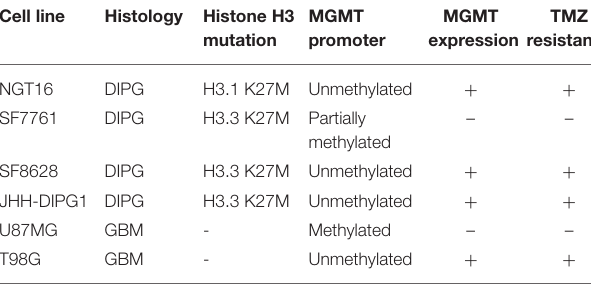
FIGURE 4 | SF7761 and U87MG are sensitive to temozolomide (TMZ). Cell viability assays showed that cell lines with reduced MGMT expression, SF7761 and U87MG, are sensitive to TMZ, whereas NGT16, SF8628, JHH-DIPG1, and T98G lines, which retain MGMT expression, were resistant to TMZ ( ⋆⋆⋆⋆ p < 0.0001; Two-way ANOVA). TABLE 1 | Characteristics of each cell line are summarized.